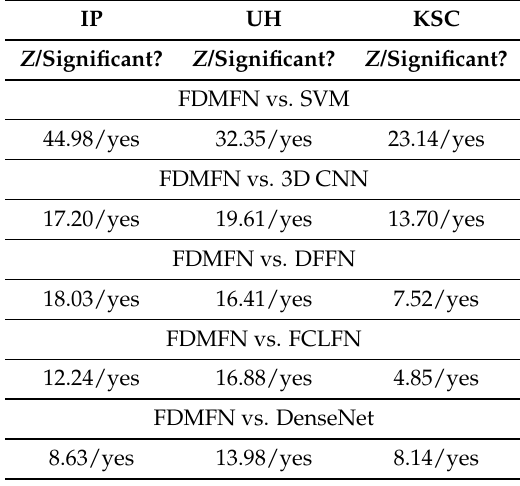
Table 9. Statistical significance of the improvement of FDMFN over other methods.